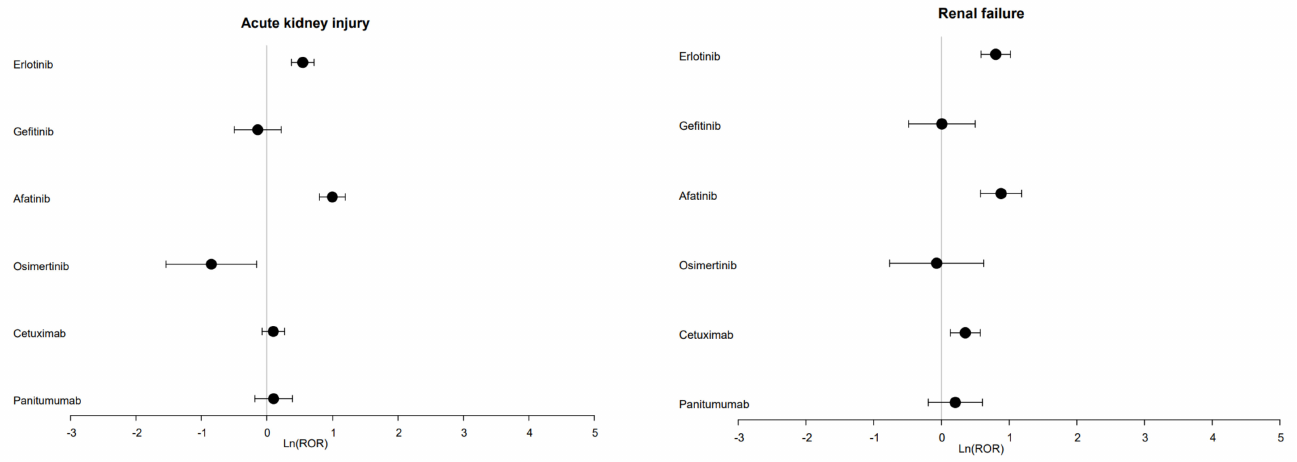
Figure 1. Forest plot of disproportionality (reporting odd ratio) of drugs targeting EGFR and acute kidney injury or renal